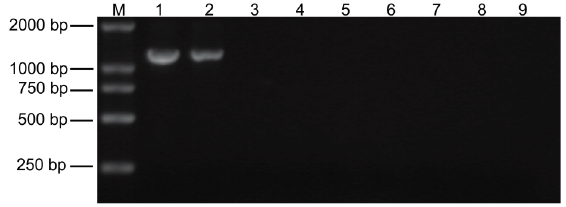
Figure 2. Phytoplasma 16SrDNA amplication in MMS treated plantlets. ( 1 ) PaWB-infected plantlets; ( 2 ) 20 mg·L − 1 MMS; ( 3 ) 60 mg·L − 1 MMS; ( 4 ) 100 mg·L − 1 MMS; ( 5 ) Healthy plantlets; ( 6 ) ddH 2 O; ( M ) DNA